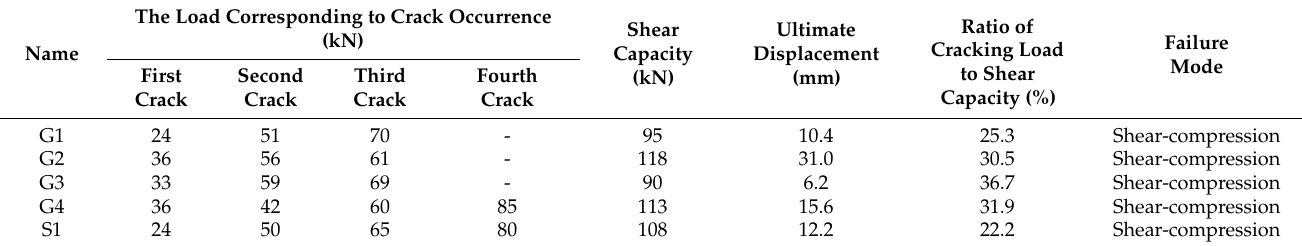
Table 3. Test results of all test specimens.